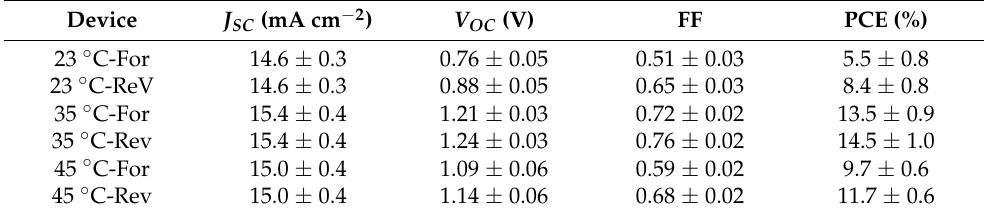
Table 1. Forward scan and reverse scan performance parameters of perovskite solar cells fabricated at 23 ◦ C, 35 ◦ C, and 45 ◦ C ambient air